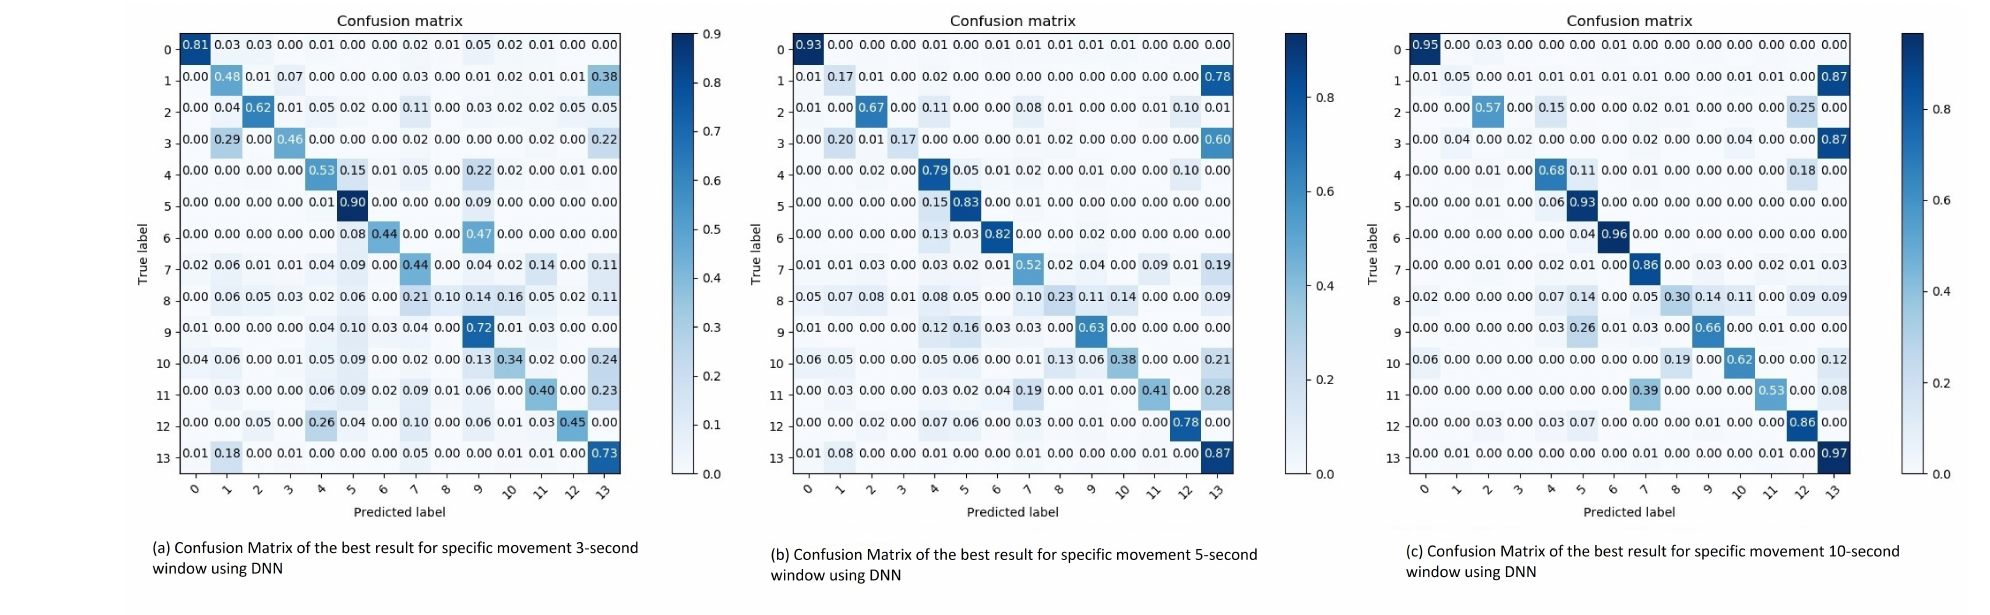
Figure 8. Confusion matrix of the best result for specific movement 3, 5, 10-s window using